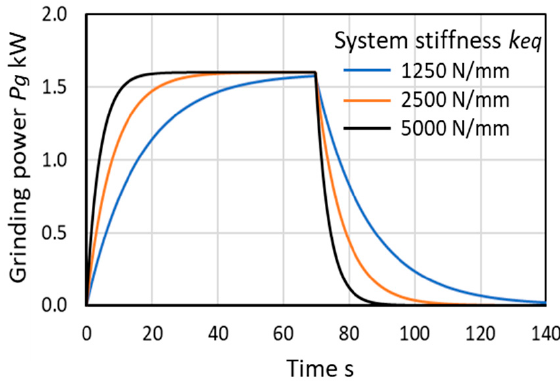
Figure 6. The e ff ect of system sti ff ness on the plunge grinding process. Figure 6. The effect of system stiffness on the plunge grinding process.